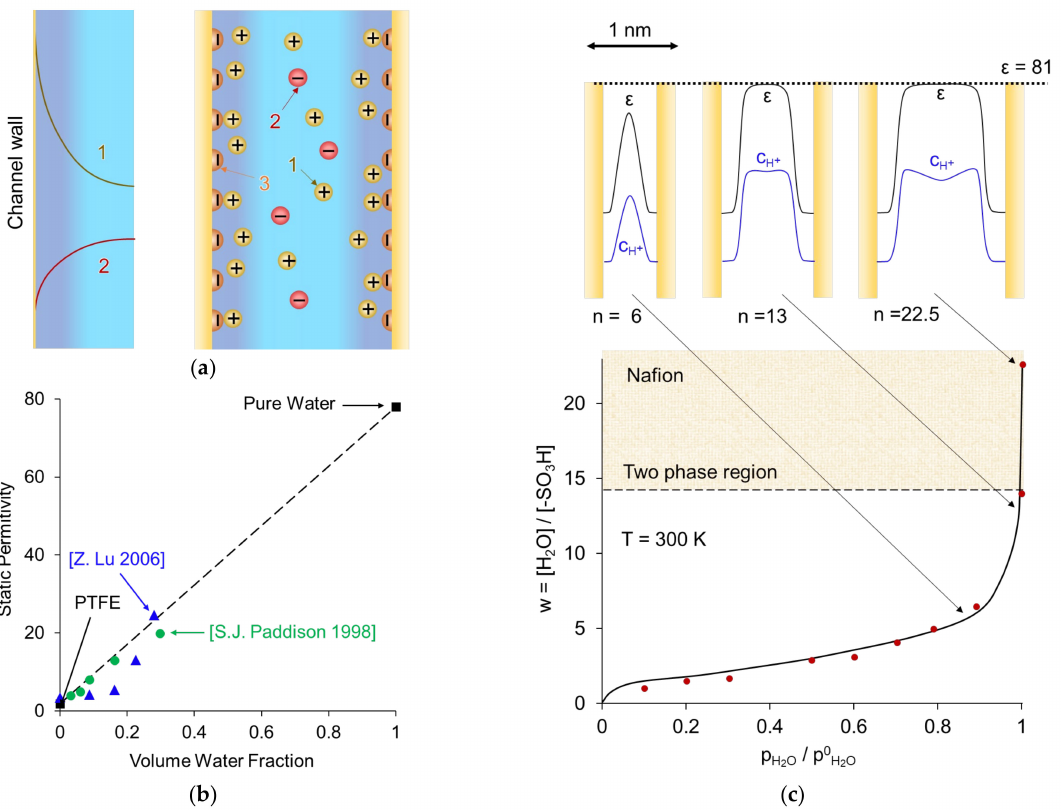
Figure 6. ( a ) Distribution of counterions (1) and coions (2) within a pore near a charged wall with fixed functional groups (3). Reproduced with permission from [52]. ( b ) Static permittivity of Nafion ® 117 measured by by Padisson et al. [49] and Lu [53], plotted as a function of the volume fraction of water sorbed in the polymer. ( c ) Hydration isotherm (water content, w , as a function of relative water vapor pressure) for Nafion 117, and the distribution of the dielectric constant and proton concentration across the hydrated hydrophilic pores for three different values of n (top). A hydrated counterion is shown near the pore wall. Adapted from